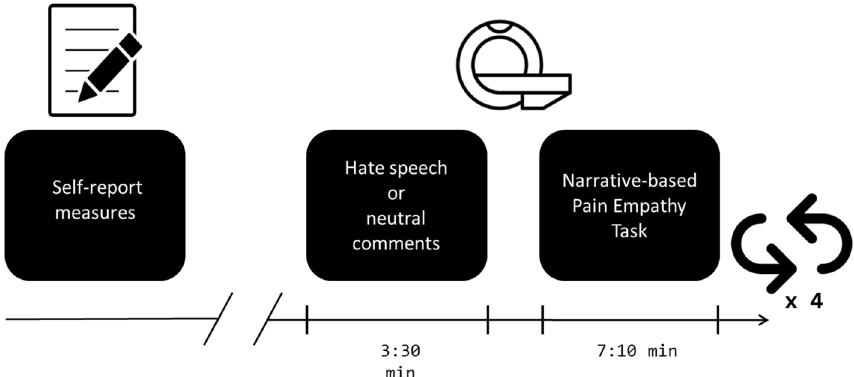
Figure 1. The design of the